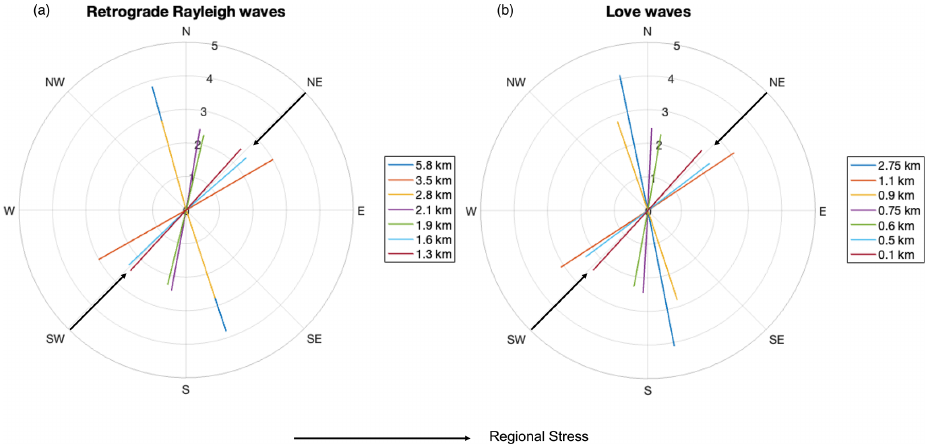
Figure 8. Fastest directions, velocity with respect to orientation, at different depths. The back arrows convey the direction of regional stress. (a) Synthetic correction for retrograde Rayleigh waves. (b) Synthetic correction for Love